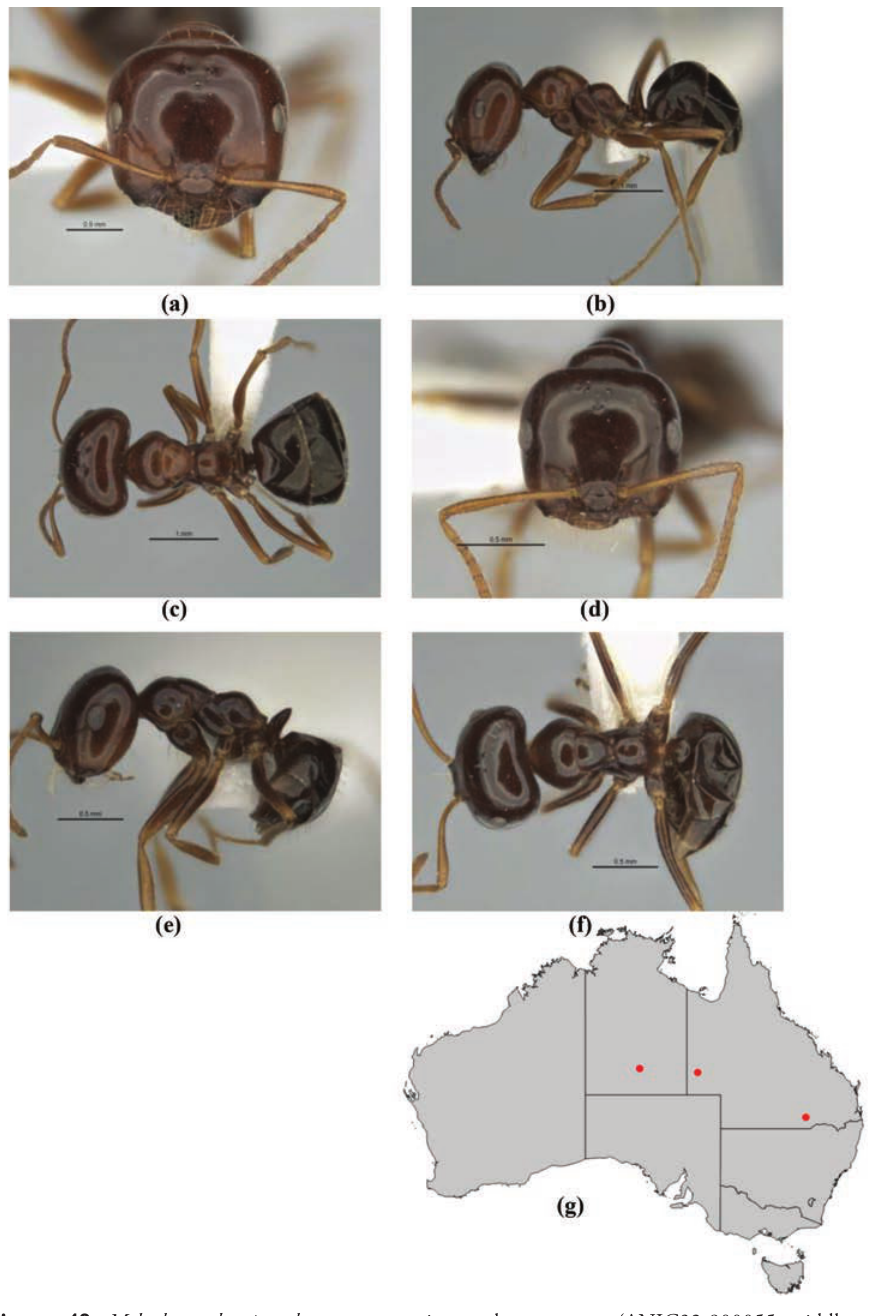
Figure 48. Melophorus brevignathus sp. n.: major worker paratype (ANIC32-900055–middle ant) frons ( a ), profile ( b ) and dorsum ( c ); minor worker holotype (ANIC32-900055–bottom ant) frons ( d ), profile ( e ) and dorsum ( f ); distribution map for the species ( g ). Low resolution scale bars: 1 mm ( b, c ); 0.5 mm ( a, d–f